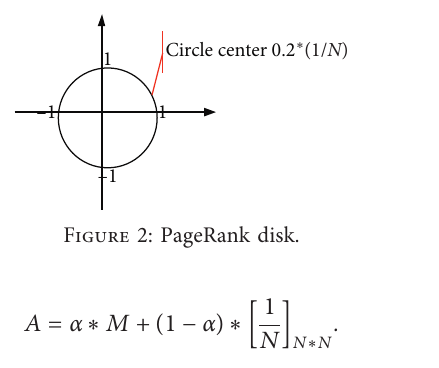
Figure 2: PageRank